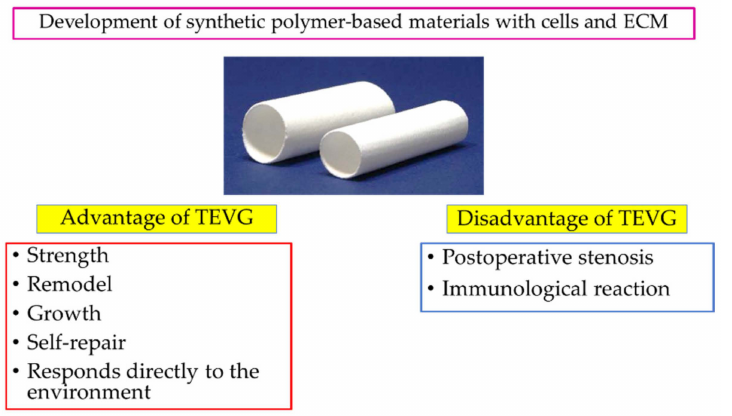
Figure 1. The advantages and disadvantages of TEVGs have emerged over years of development. Recently, the focus has been on the development of next-generation TEVGs with cells and ECM in synthetic polymer-based materials. The image was produced by the authors using the photos provided by Gunze Ltd. (Tokyo,